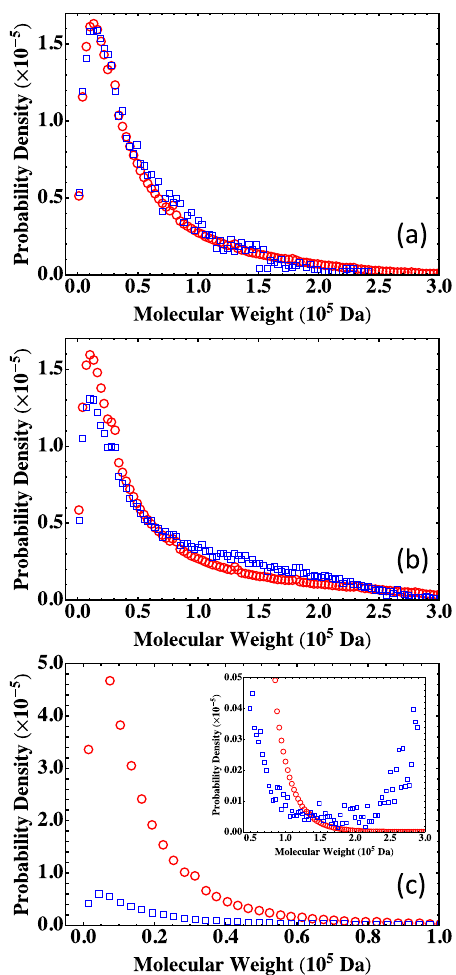
Figure 5. MWD for the three systems in Table 2: ( a ) S < with α < α c , ( b ) S (cid:39) with α (cid:39) α c , and ( c ) S > with α > α c , with the inset showing data in the region of high molecular weight. The results are for the Flory-Stockmayer theory (red circles) and the MC simulations (blue squares). The MC results are the averages of 1000 runs for S < , and 10,000 runs for S (cid:39) and S >